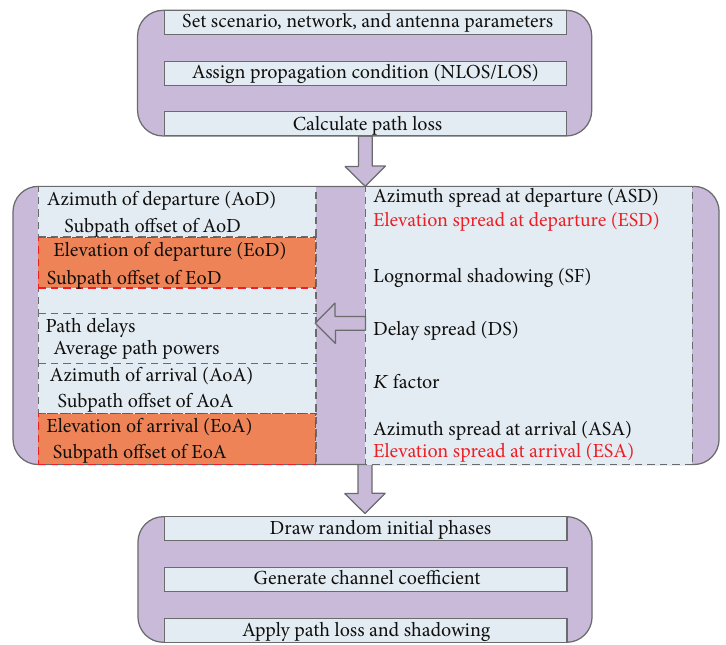
Figure 3: The procedure of 3D channel model [11, 12].